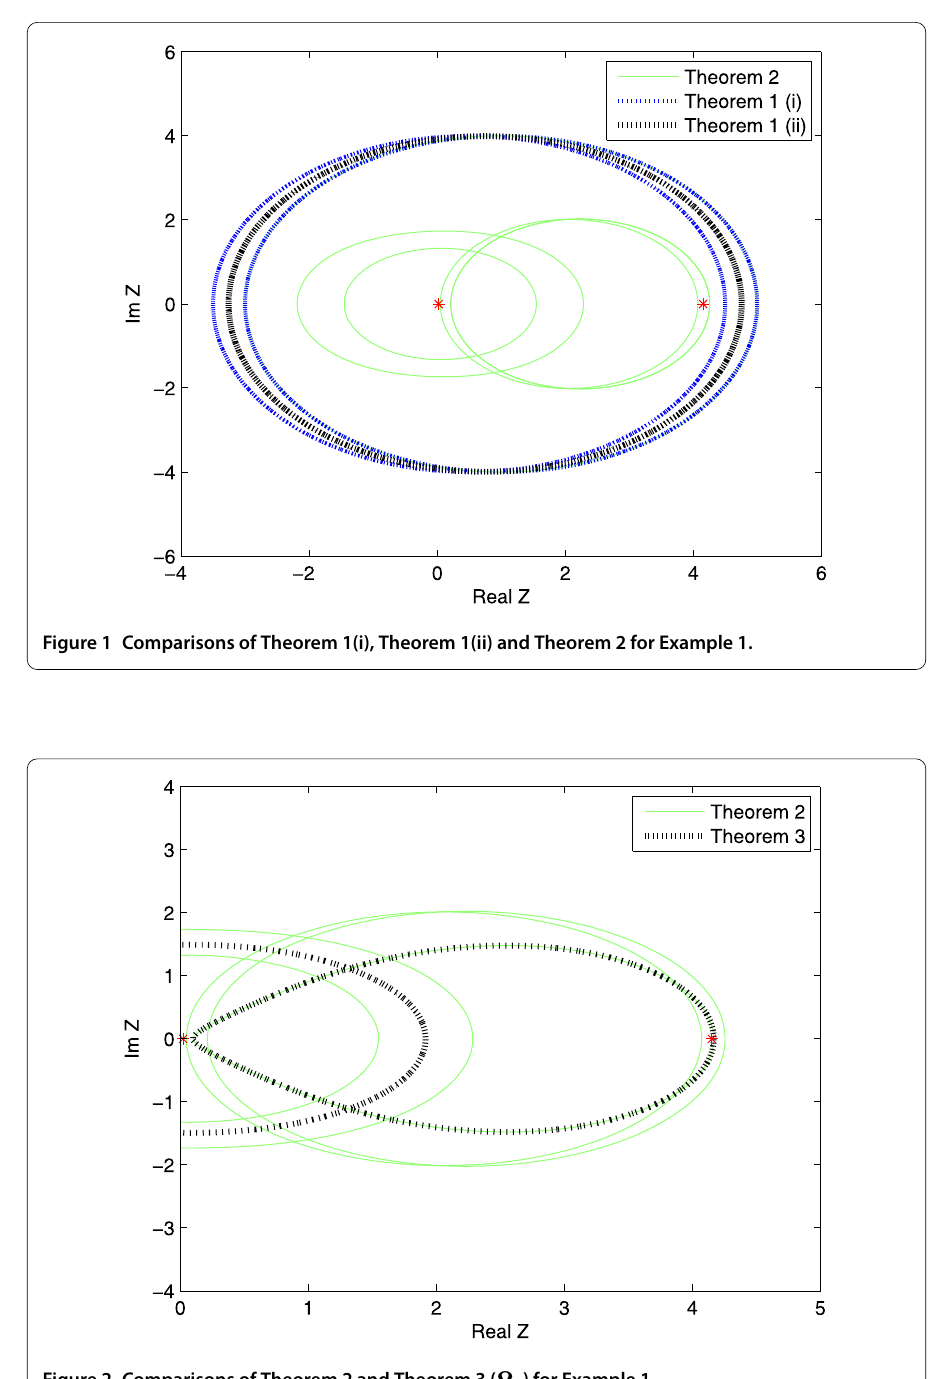
Figure 2 Comparisons of Theorem 2 and Theorem 3 ( (cid:2) 3 ) for Example